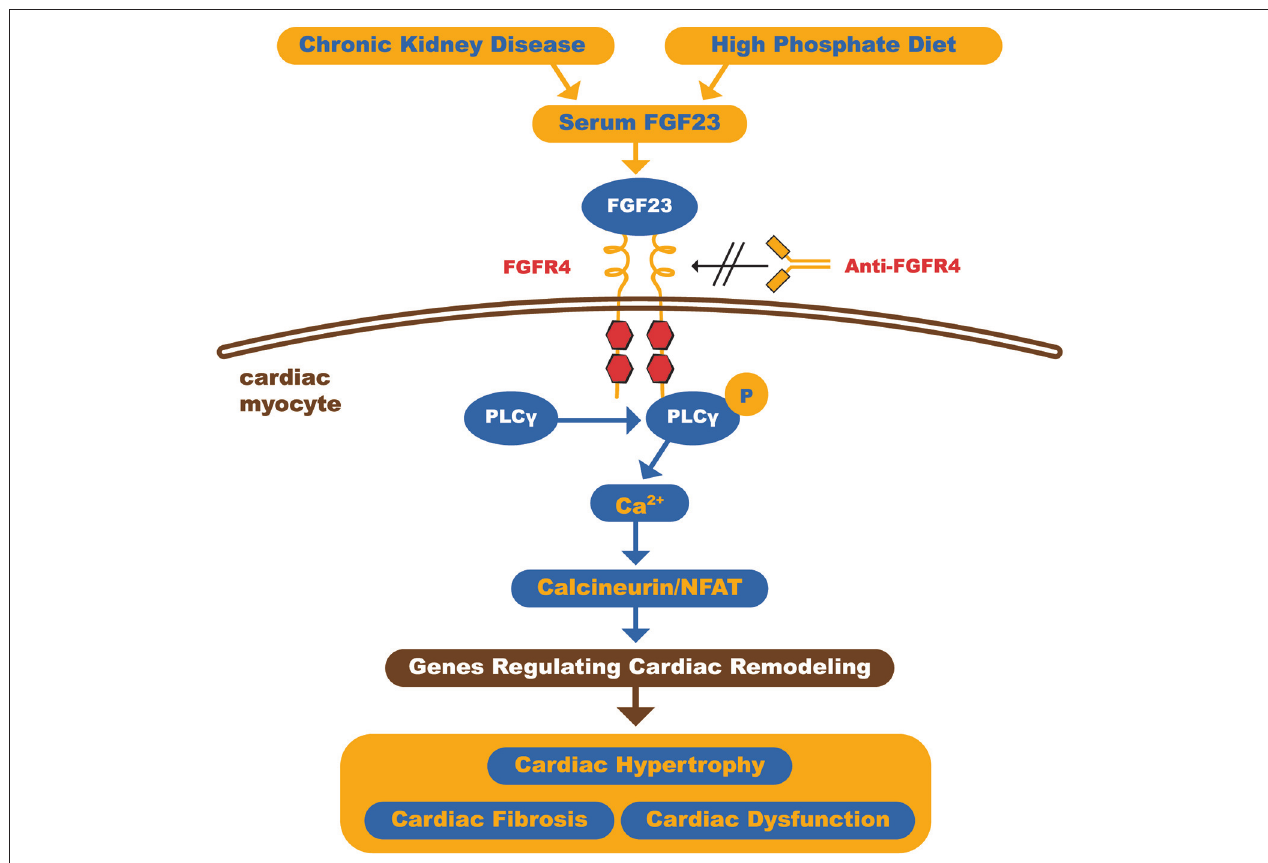
FIGURE 3 | Schematic representation of how FGF23 can induce cardiomyocyte hypertrophy. The high circulating FGF23 levels in CKD patients can activate FGFR4 in cardiac myocytes and, through calcineurin/NFAT signaling pathway, activates cardiac remodeling genes, leading to hypertrophy and fibrosis. On the other hand, FGFR4 blockade by anti-FGFR4 can attenuate cardiac hypertrophy. FGF23, Fibroblast growth factor 23; FGFR4, type 4 Fibroblast growth factor 23 receptor; PLC γ , Phospholipase C γ ; NFAT, Nuclear factor of activated T-cells. Adapted from Grabner et al.